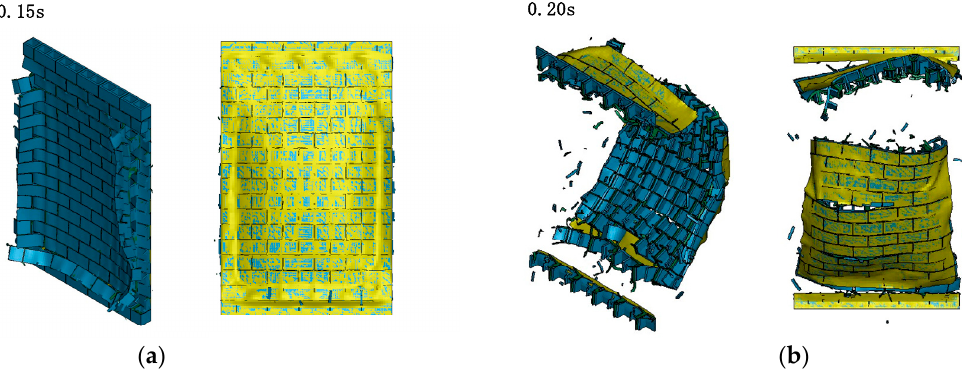
Figure 13. Influence of boundary constraints at the SPUA layer to damage pattern under different loadings: ( a ) Load 1; ( b ) Load 2.